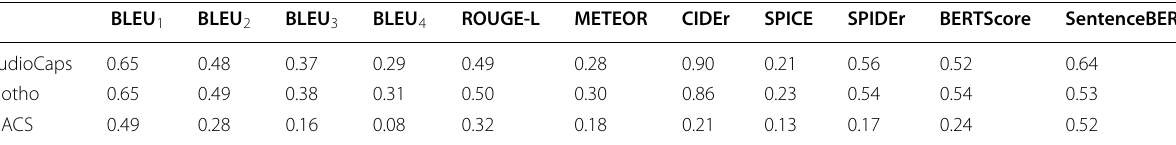
Table 4 Consensus scores of English-annotated